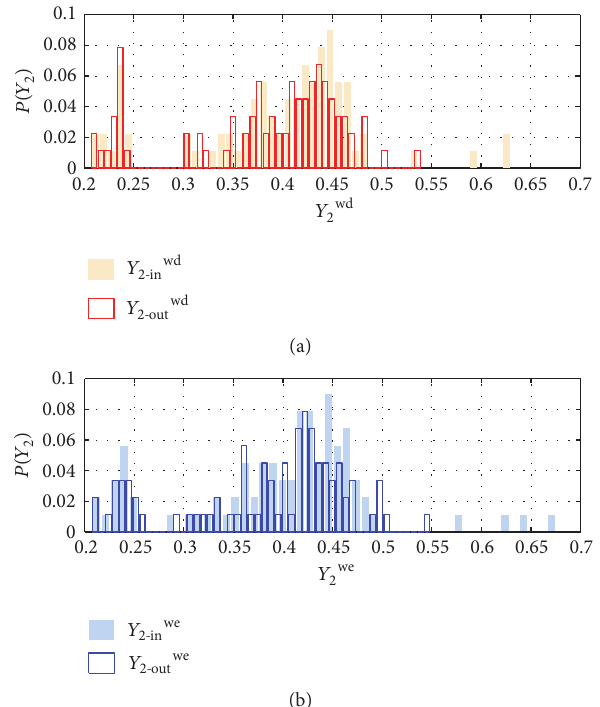
Figure 6: The probability distributions of 𝑌 2 for both incoming and outgoing flows on (a) weekday and (b) weekend. The distributions on weekday are peaked for 𝑌 2 both concentrated in the range (0.20, 0.25) and (0.30, 0.48). The distributions on weekend are peaked for 𝑌 2 0.43 and both concentrated in the range (0.20, 0.26) and (0.30, 0.50).